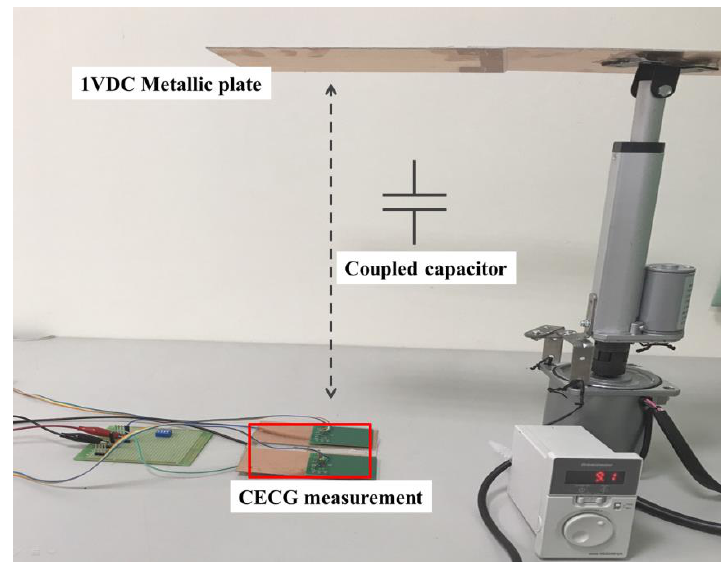
Figure 9. A photo of the built noise-resistant performance testbed.